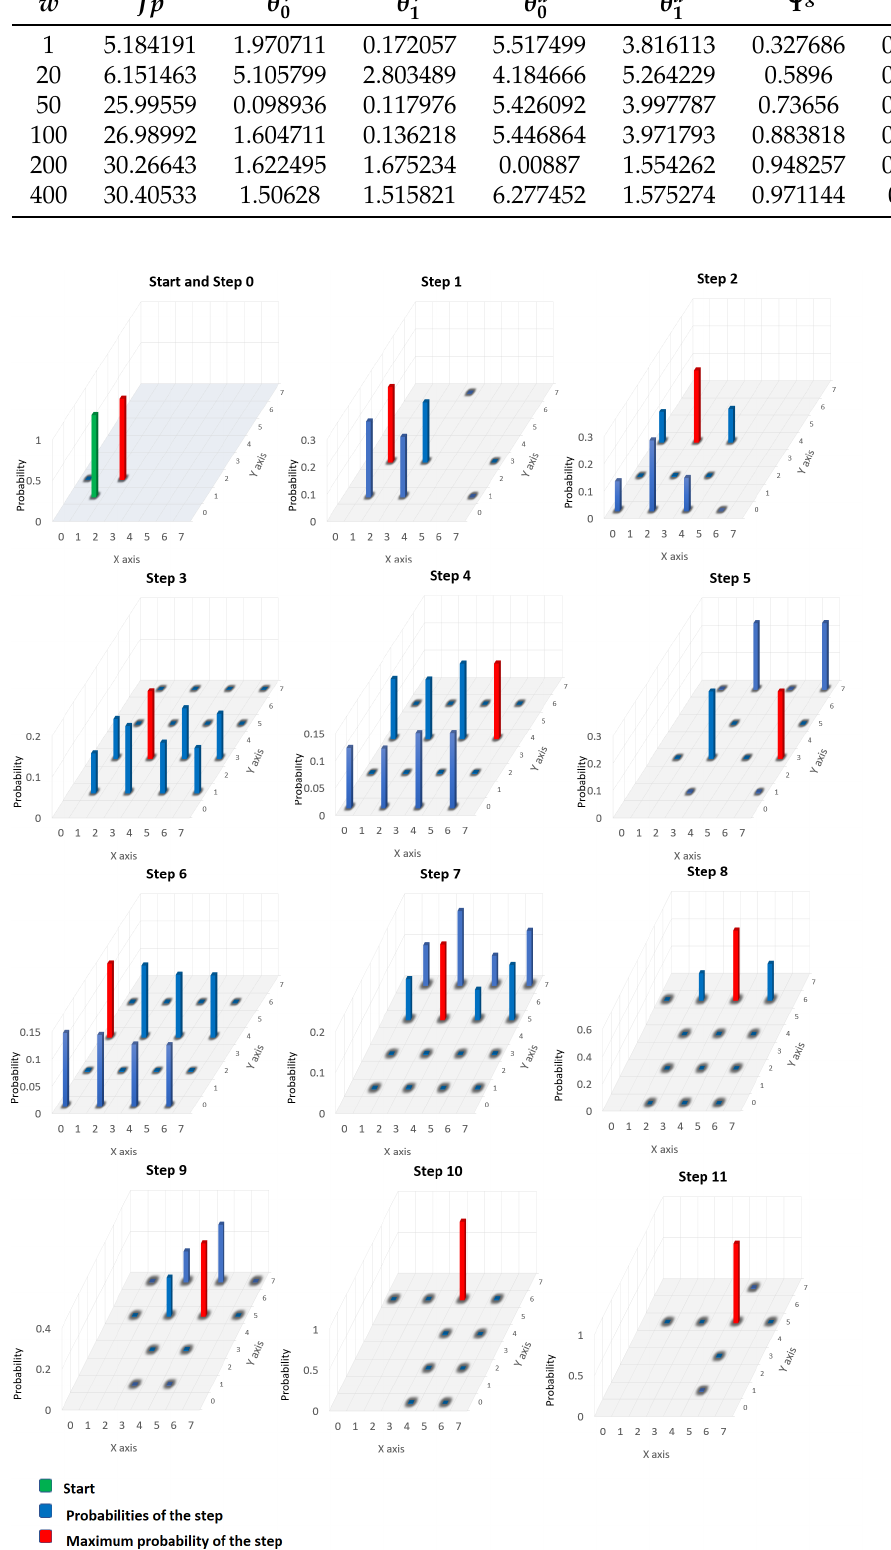
Figure 19. The representation of the probabilities of the best individual for